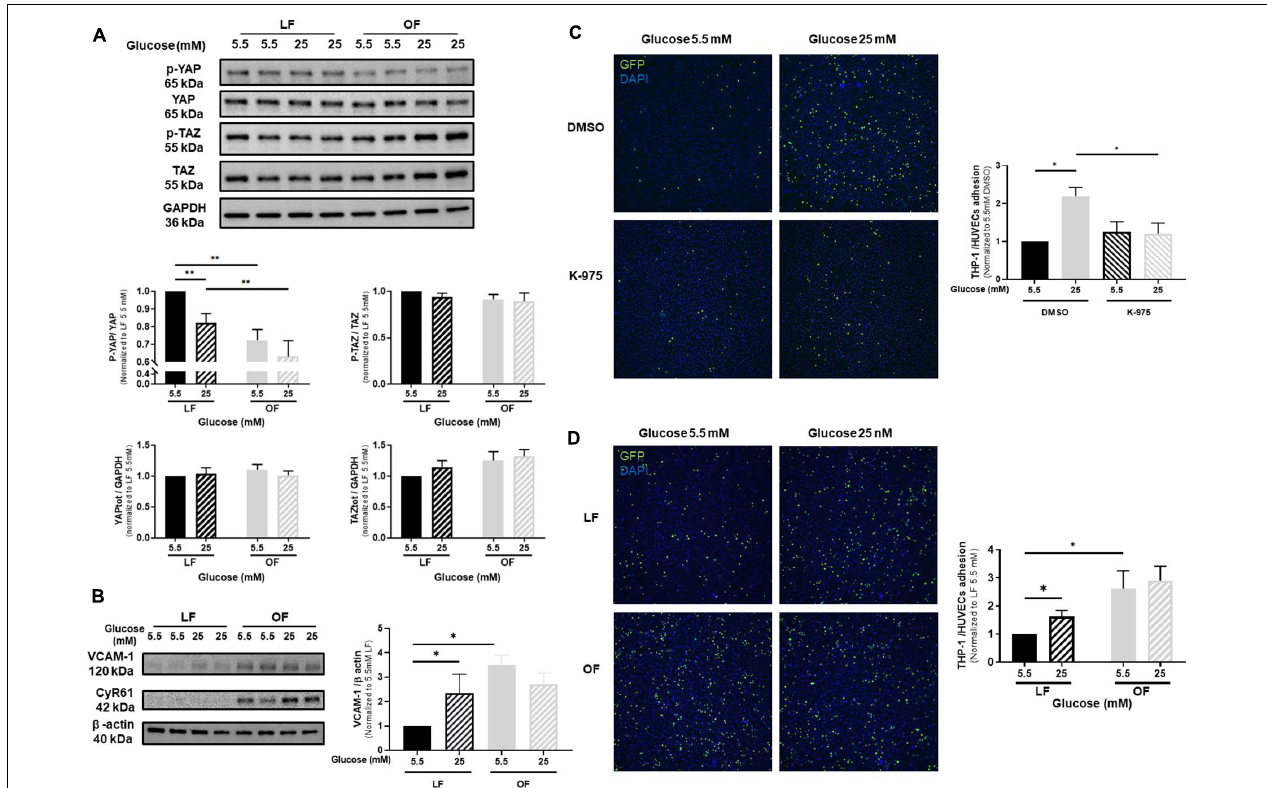
FIGURE 3 | Effects of high glucose and shear stress on YAP activation in endothelial cells. (A) Representative protein expression blots and bar graphs of phospho and total YAP, phospho and total TAZ in HUVECs cultured under either normal or high glucose and subjected to either laminar flow (LF, 12 dyn/cm 2 ) or oscillatory flow (OF, 0.5 ± 6 dyn/cm 2 ; 1 Hz) for 72 h. (B) Representative protein expression blots of VCAM-1 and CYR61 and bar graphs of VCAM-1 in HUVECs cultured under either normal or high glucose and subjected to LF or OF for 72 h. (C) Representative microphotographs and bar graphs showing THP-1 monocyte attachments to HUVECs cultured under either normal or high glucose, subjected to LF for 72 h and additionally treated with the YAP/TEAD inhibitor K-975 (200 nM). DMSO was used as control for K-975. (D) Representative microphotographs and bar graphs showing THP-1 monocyte attachments to HUVECs cultured under either normal or high glucose and subjected to either LF or OF for 72 h. THP-1 monocytes are GFP positive (green fluorescence). Nuclei are stained by DAPI (blue fluorescence). Data are presented as the mean ± SEM. N = 4–11/group for panel A; N = 6–15/group for panel B; N = 4–5/group for panel C and N = 5–6/group for panel D. ∗ p < 0.05 and ∗∗ p < 0.01 between the indicated groups. Two-tailed Mann-Whitney test (A,C,D) or two-tailed Student’s t test (B) was used for comparisons between the